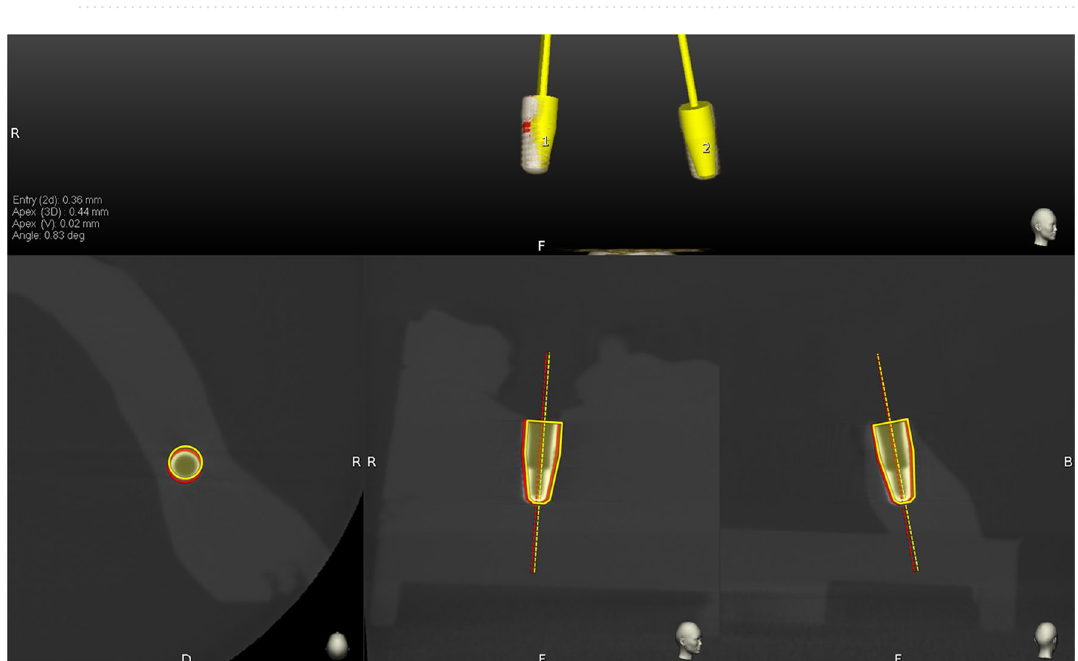
Figure 4. Superimposition of planned and actual placed implant